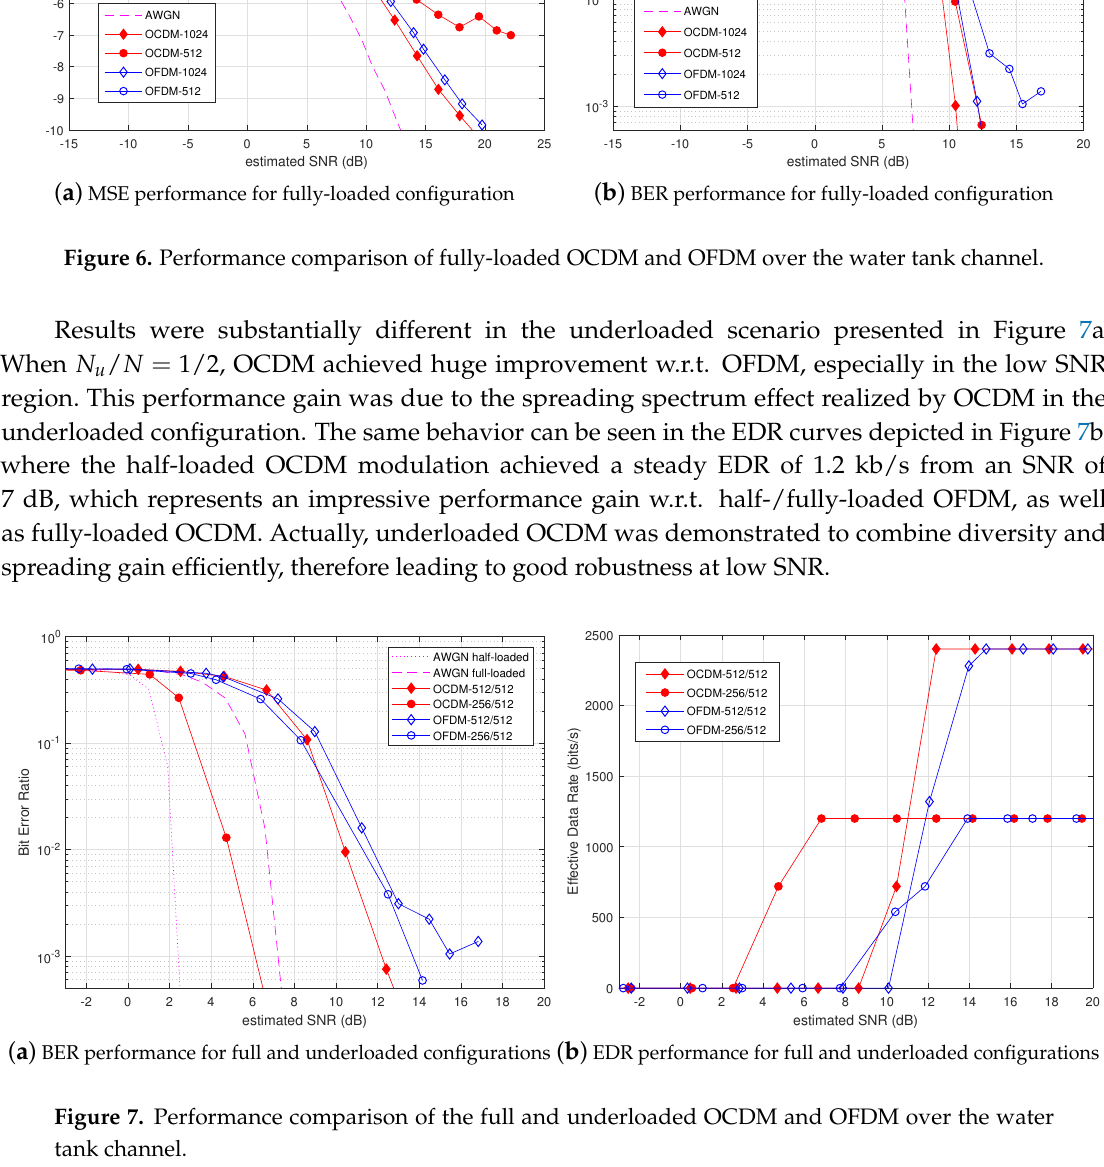
Figure 7. Performance comparison of the full and underloaded OCDM and OFDM over the water tank